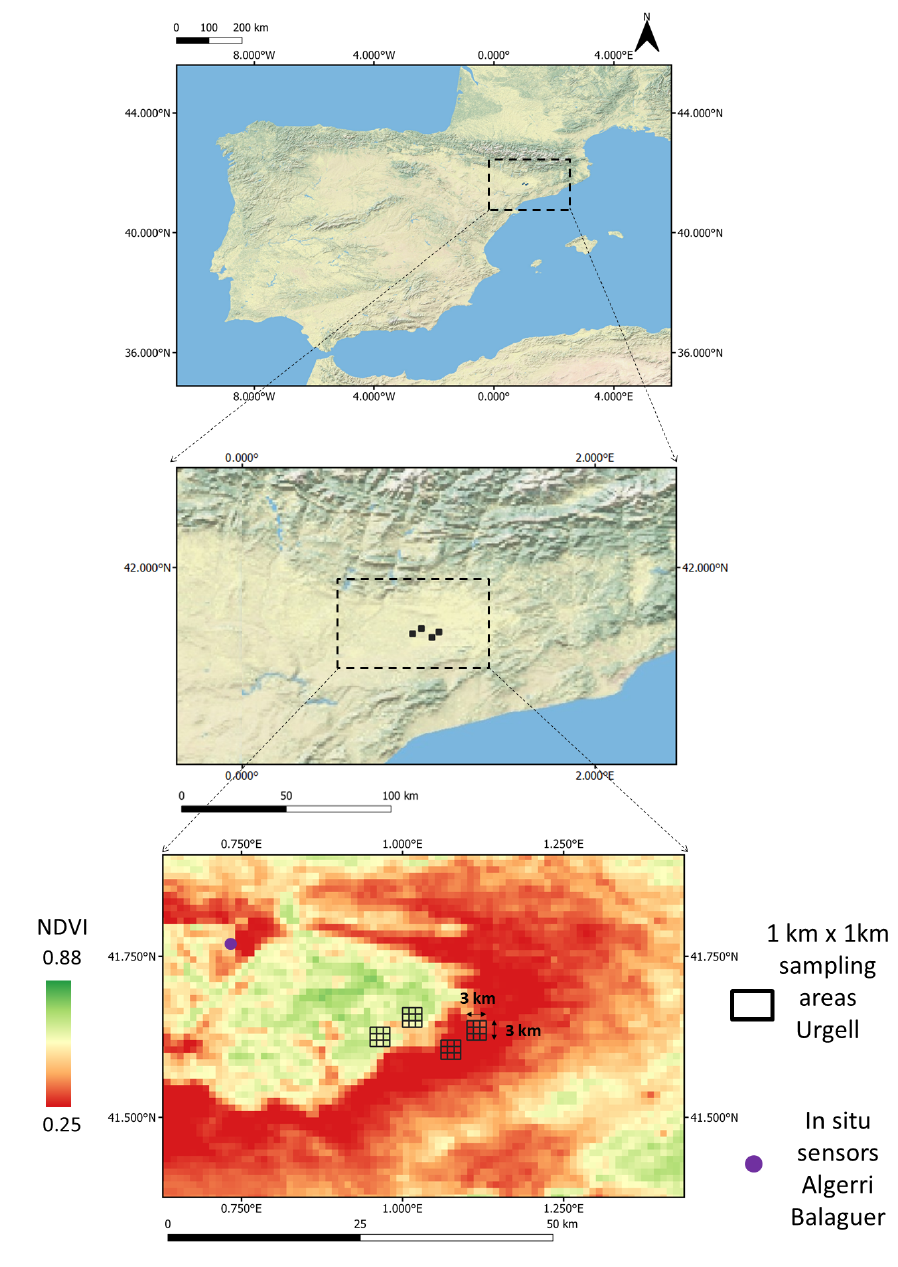
Figure 1. The Urgell and Algerri-Balaguer study